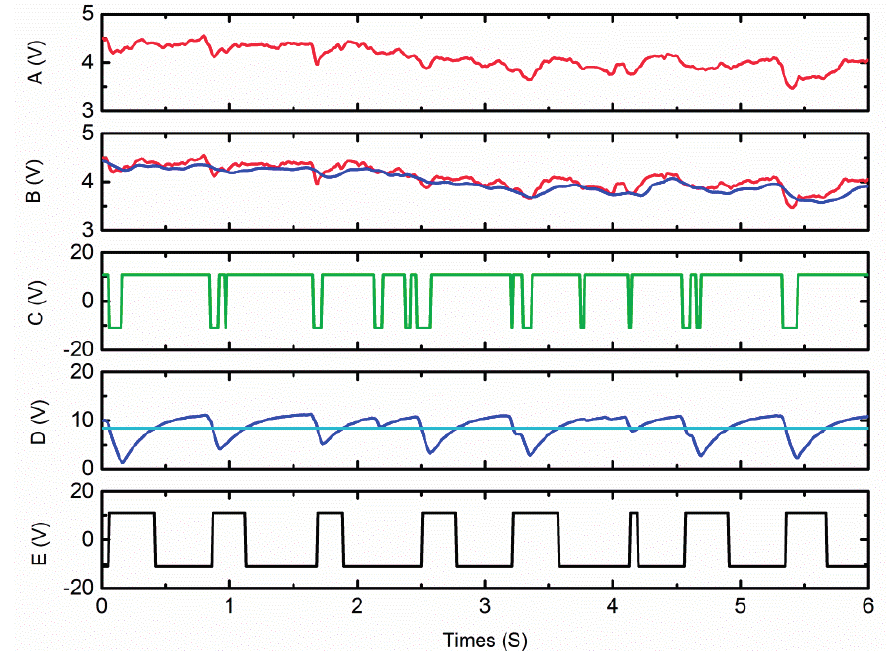
Figure 7. Input signal and output signal of the ASP subsystem. Traces’ name correspond to the output shown in Figure 1.